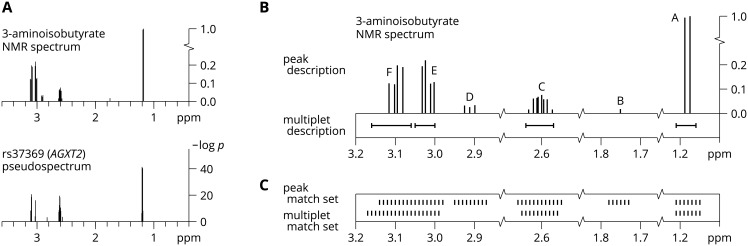
AGXT2 pseudospectrum and 3-aminoisobutyrate NMR spectrum, descriptions, and metabomatching match sets.(A) The upper plot shows the experimental NMR spectrum of 3-aminoisobutyrate. The lower plot shows the (-log) p-values of the pseudospectrum of rs37369 in AGXT2, when p < 10−3. There is a close match between the experimental spectrum and the pseudospectrum, as the four sets of features that associate (p < 5 × 10−8) with rs37369 correspond to the principal peaks of the spectrum. (B) Taking a more detailed view of the spectrum descriptions (from HMDB), we see that the peaks of 3-aminoisobutyrate group into six clusters (labeled A through F). The multiplet ranges for clusters A, C, and E enclose their corresponding peaks well, padding by an average of 0.023 ppm. The multiplet range for cluster F is significantly wider, padding by 0.062 ppm. Approximating cluster areas as the product of the width of the cluster with the average height of the peaks in the cluster, then scaling, we find area-derived proton counts of 2.8, 0.7, 1.1, 1.2 for clusters A, C, E, and F, respectively. These counts are coherent with the listed proton counts of 3, 1, 1, and 1 for the respective multiplet ranges. Applying this same approximation for clusters B and D results in area-derived proton counts of 0.0, and 0.2. Because this implies corresponding multiplet proton counts of 0, we may consider the two spectrum descriptions essentially coherent, even though no multiplet ranges are listed for clusters B and D. (C) Match sets obtained from the peak and multiplet descriptions of the 3-aminoisobutyrate spectrum, for features resulting from a uniform NMR spectrum binning in 0.01 ppm increments, and with neighborhood parameter δ = 0.03 and 0.01, respectively. While the peak and multiplet descriptions of the 3-aminoisobutyrate NMR spectrum may be essentially coherent, their resulting match sets do differ, with 22 features unique to either one of the match sets.